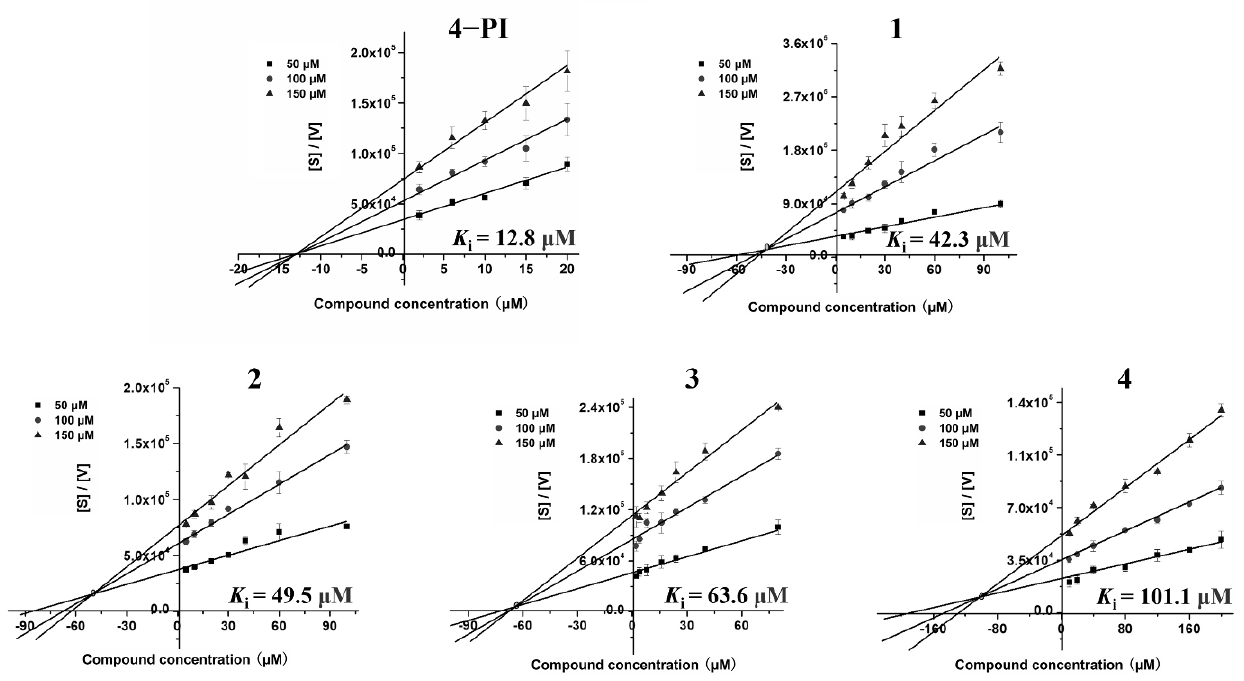
Figure 5. Four inhibitors are tested through IDO1 inhibitory activity assays with 4 − PI as a positive control. The IC 50 values are presented as the mean ± SD with three independent determinations.